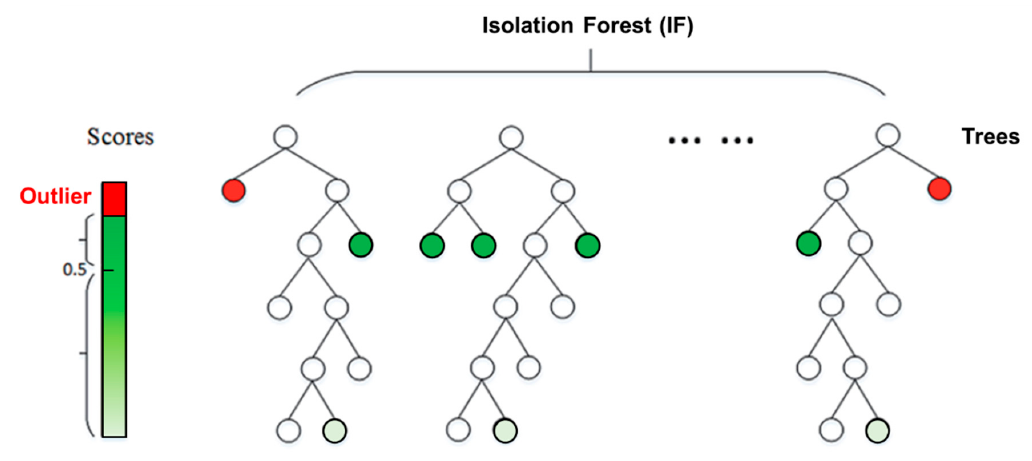
Figure 3. Overview of the isolation forest method. Light green circles represent common normal samples, dark green circles represent uncommon normal samples, and red circles represent outliers.